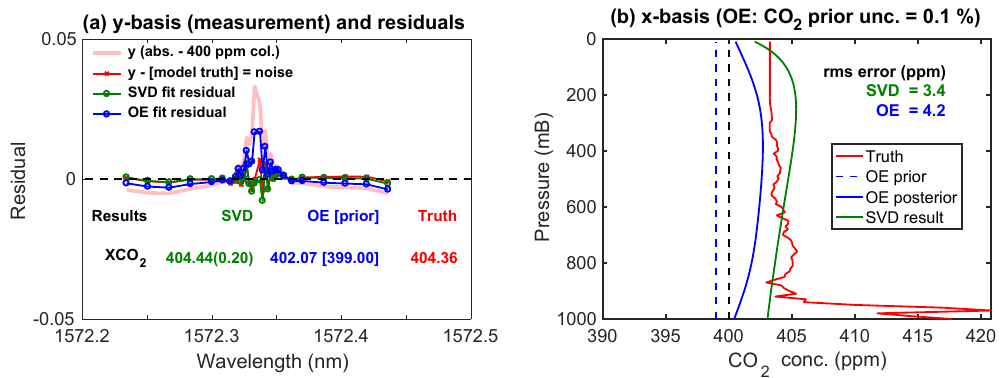
Figure 7. Sample retrieval for a single simulated measurement under strong constraint (one principal component for SVD, 0.1% prior uncertainty for each CO 2 level for OE). (a) Both the SVD and traditional OE approaches produce persistent residuals well above the noise levels due to the strong constraint. For the SVD method, the X CO column mean (first principal component in the z basis) is nevertheless 2 bias-free. However, the OE method shows a bias when the results are projected to the z basis. (b) Results projected to the x basis also show a clear bias for the OE method, though the CO 2 profile is well behaved. This shows that, when using the Bayesian prior as a regularization to get a well-behaved CO 2 profile, one runs the risk of overconstraining the retrieval and incurring a bias in the column mean. See Fig. 8 (right) for ensemble results.